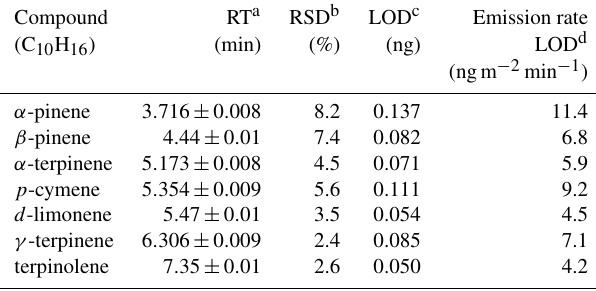
Table 2. Summary of monoterpenes quantified using TD